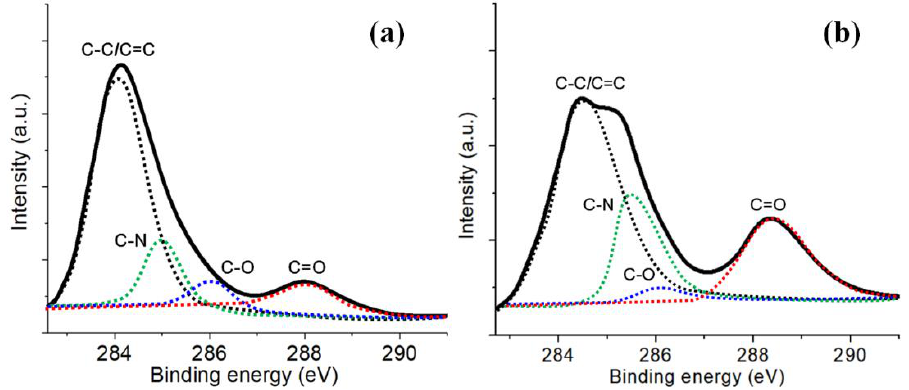
Figure 10. Deconvolution of C 1 s spectra of ( a ) pristine PI film and ( b ) PI film modified by Ar/H 2 O microplasma jet.